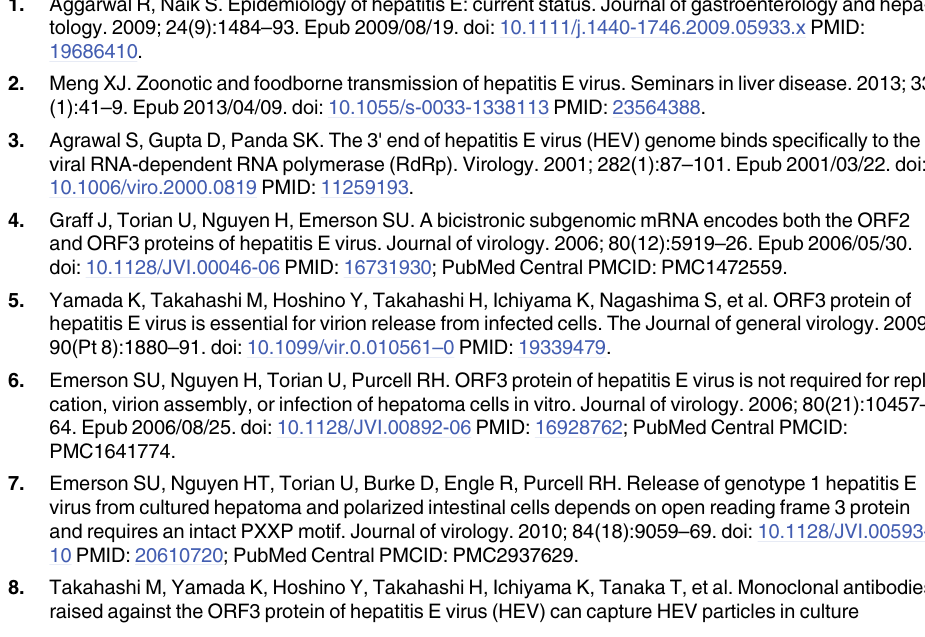
S1 Fig. The binding effect of virus to cells, the X-axis is the time post incubation with sam- ples and the Y-axis was the binding RNA content to cells. (TIF) S2 Fig. The ORF2 protein content distribution of the ORF2 negtive control and the mix- ture. (TIF) S1 Table. The specific packaging of proteins to HEV RNAandsendai virus RNA.